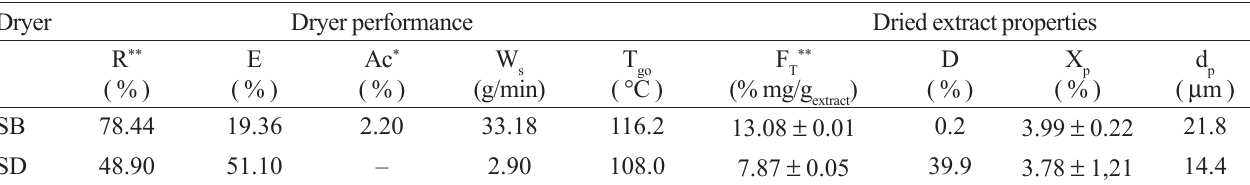
TABLE III - Spray and spouted bed dryers performance and properties of the dried extracts